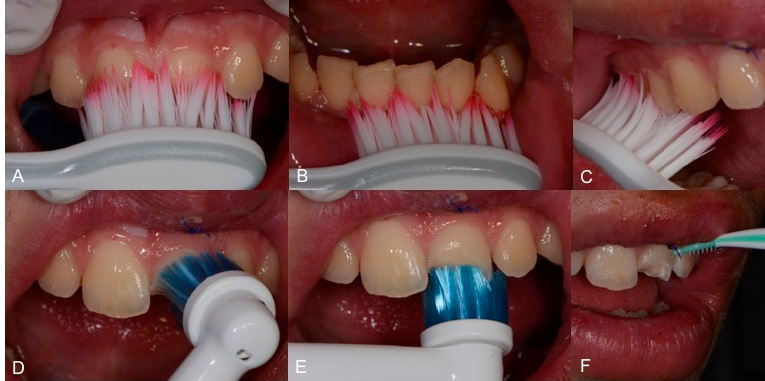
Figure 10. ( A ): Upper incisor brushing with manual toothbrush; ( B ): lower incisor brushing with manual toothbrush; ( C ): upper lateral brushing with manual toothbrush; ( D , E ): upper and lower incisor brushing with electric brush; ( F ): interdental cleaning with rubber flexile brush.